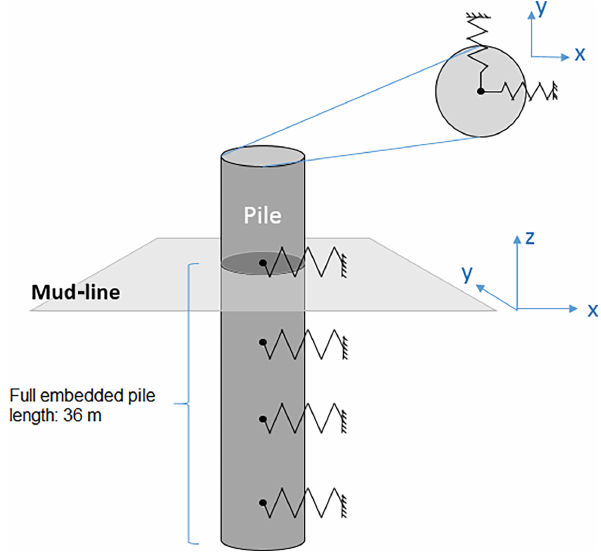
Figure 2. Model 1 applies non-linear p – y curves along the im- mersed part of the pile. The p – y curves are applied to both horizon- tal directions. The bottom of the pile is restrained against translation in the z direction and rotation around the z